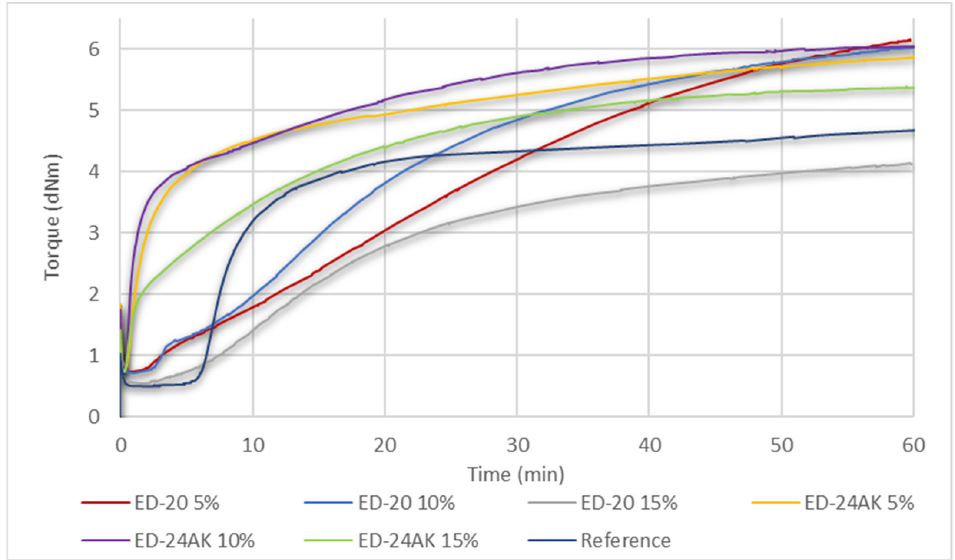
Figure 3. Vulcanization kinetics of rubber vulcanizates studied.